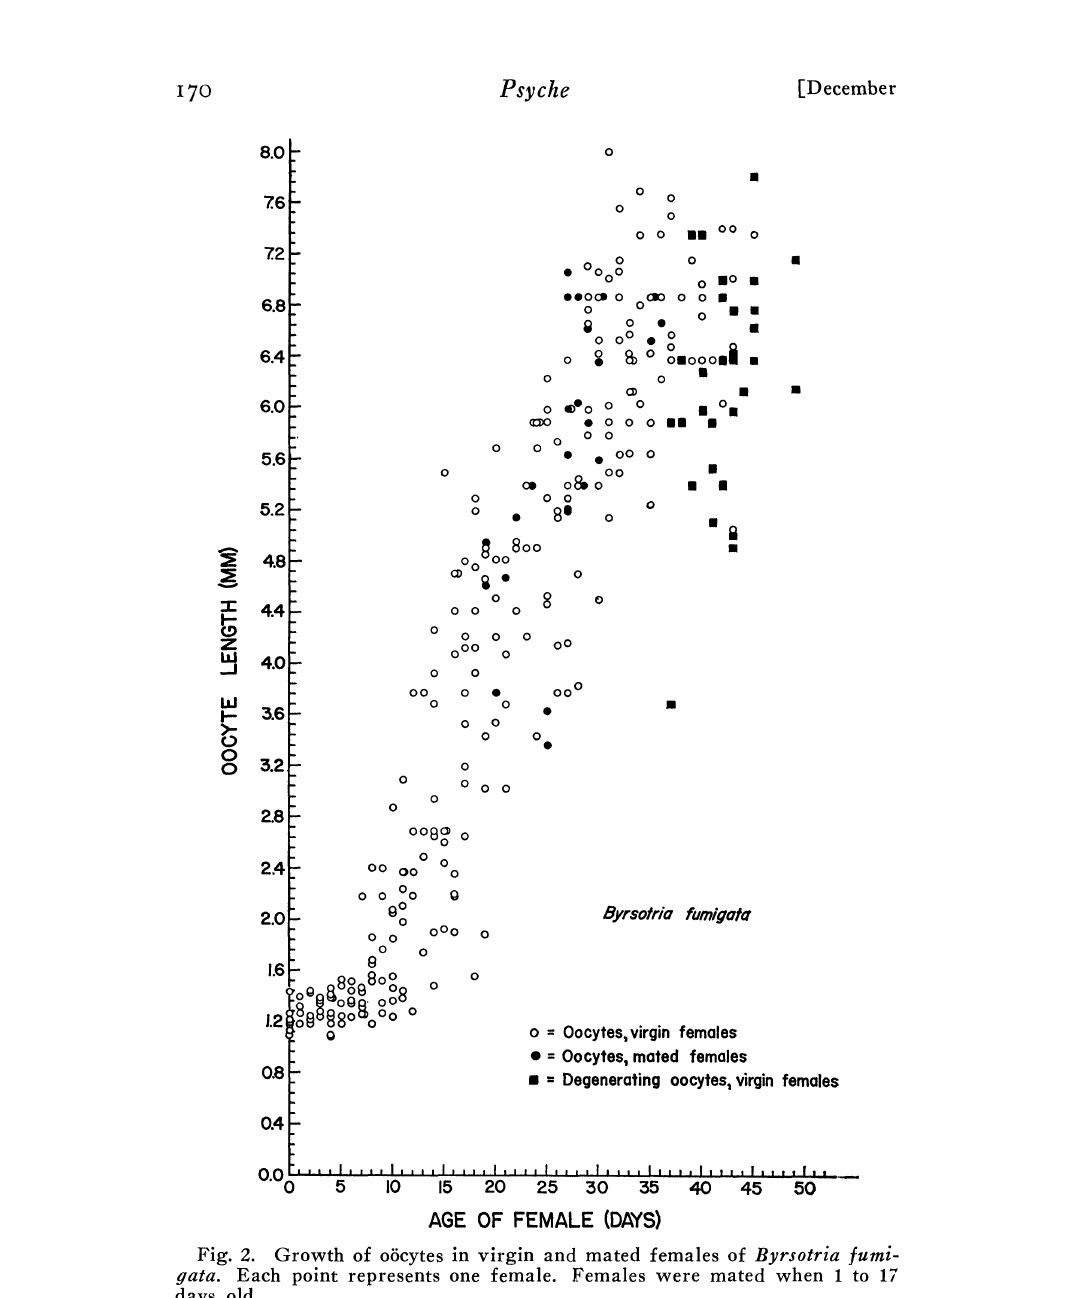
Fig. 2. Growth of o6cytes in virgin and mated females of Byrsotria fumi- gata. Each point represents one female. Females were mated when to 17 days